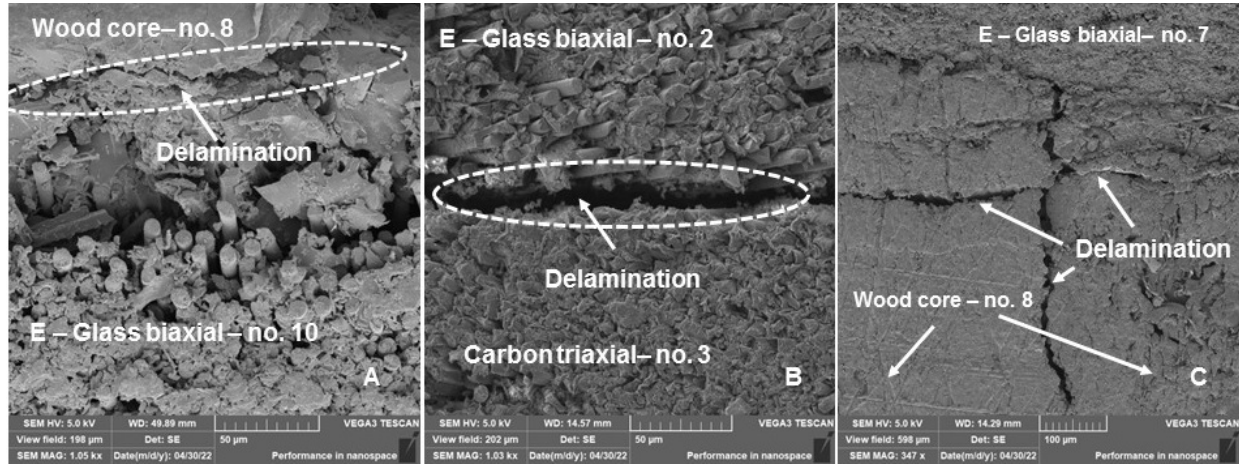
Figure 13. Cross-section of the hybrid sandwich ski structure after the end of long-term low-cycle fatigue, i.e., 70,000 cycles—SEM pictures: ( A ): Delamination of the wood core layer (No. 8) and E-Glass biaxial (No. 10) composite layer (MAG 1050×), ( B ): Delamination between E-Glass biaxial (No. 10) and carbon triaxial (No. 11) composite layers (MAG 1030×), ( C ): Delamination of wood core (No. 8) and its interaction with E-Glass biaxial (No. 10) (MAG 347×).